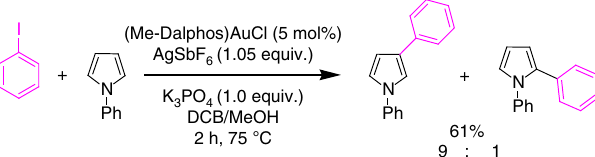
Fig. 7 Gold-catalyzed arylation of 1-phenylpyrrole with iodobenzene. Reaction carried out using the (Me-Dalphos) AuCl complex 1 (5 mol%)